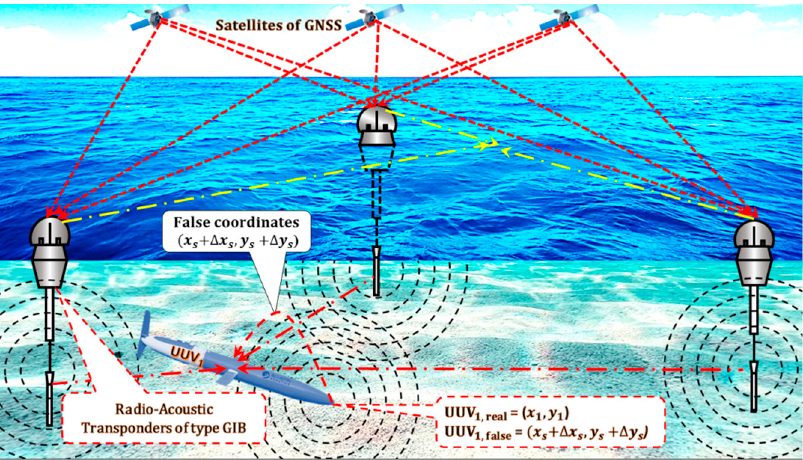
Figure 12. The basic spoofing scheme of UUVs: at some point in time, the spoofer determines its position ( x s , y s ) , introducing some delays into each of the GIBs channels, introducing some other signal distortion, and transmitting the false position ( x s , y s ) on the same frequency of GIBs, which aims to deceive acoustic receivers and create a false PVT solution. All UUVs in the spoofer activation zone are positioned as UUV i,false = ( x s + ∆ x s , y s + ∆ y s